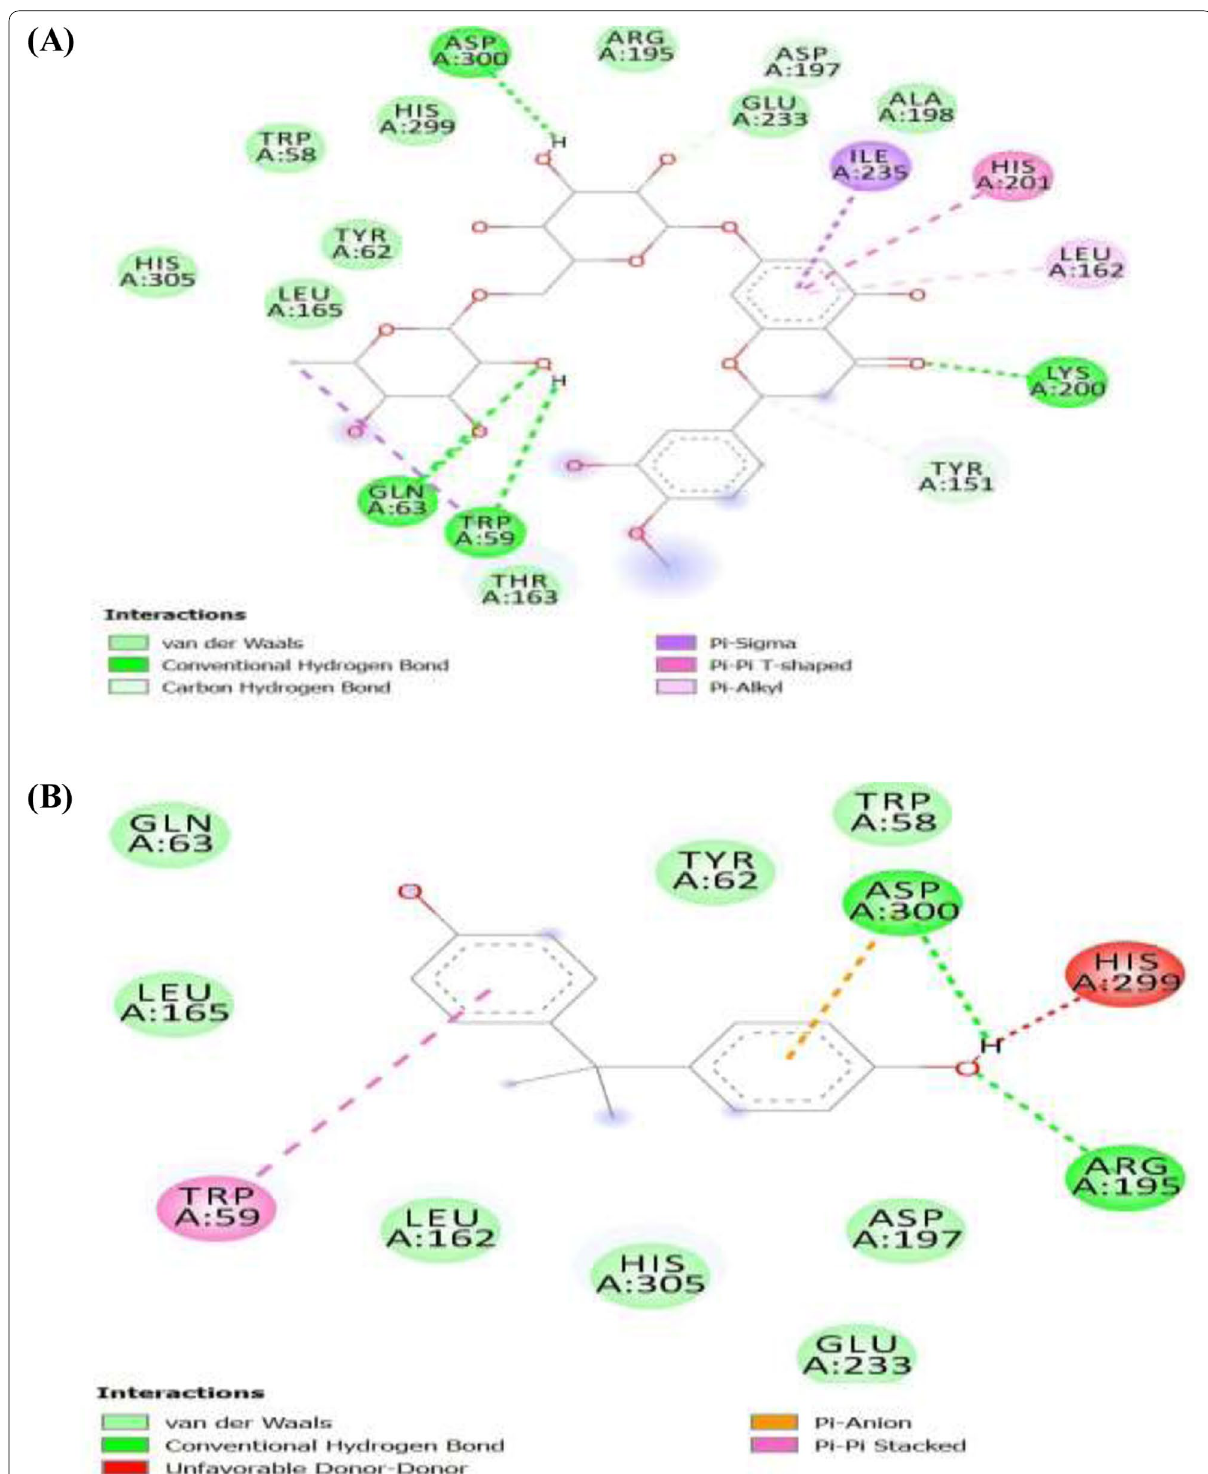
Fig. 8 α-amylase-ligands interaction. (A) . Hesperidin. (B) . Bisphenol A. Deeper green: conventional hydrogen bond; light green: van der Waals; Pink-violet: π-T shape/alkyl/sigma; brown: π-cation/anion. Red: unfavourable donor-donor; grey: carbon-hydrogen